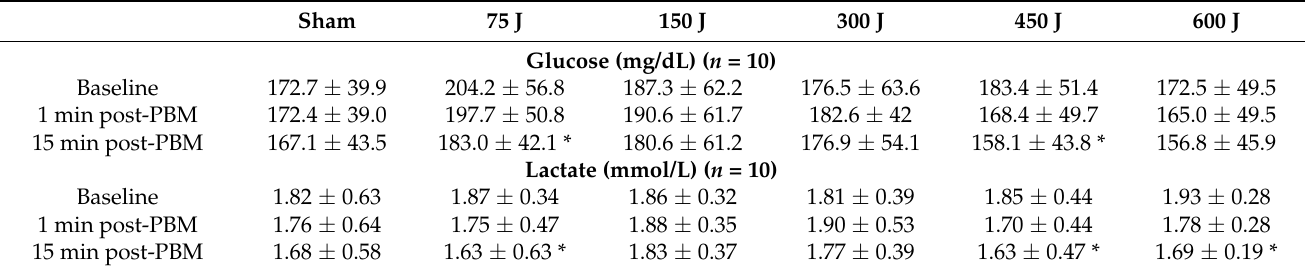
Table 3. Mean and standard deviation of metabolic variables at baseline, 1 min and 15 min post-PBM for sham energies, 75, 150, 300, 450, and 600 J.